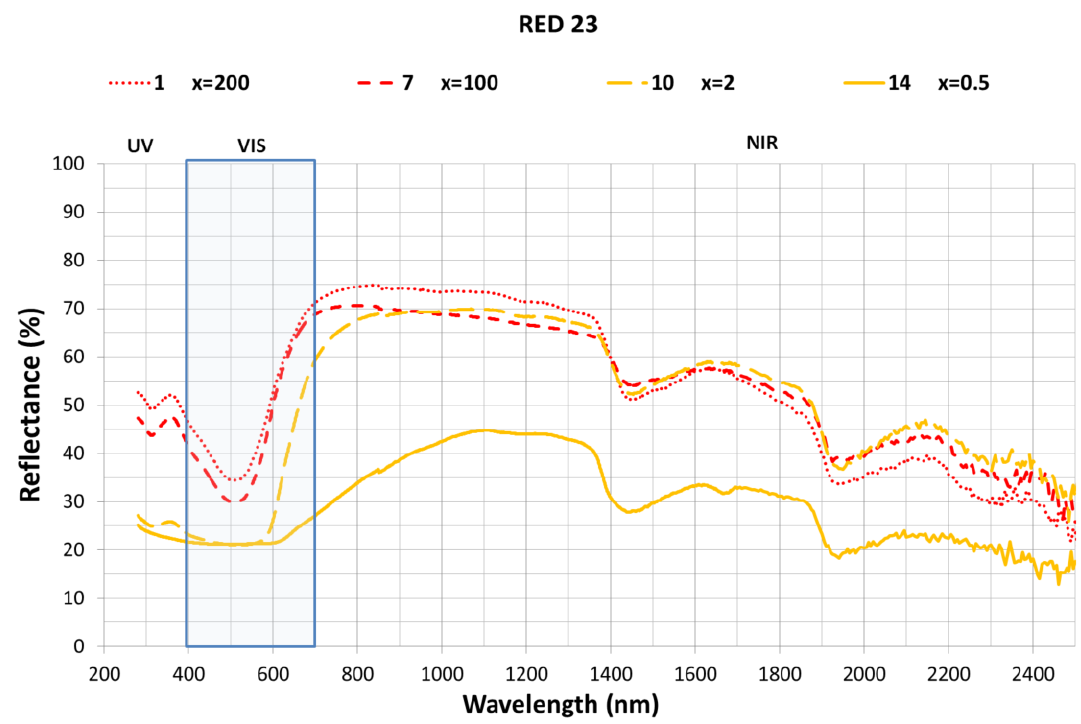
Figure 4. TSR (%) for RED 23 dye hybrid.